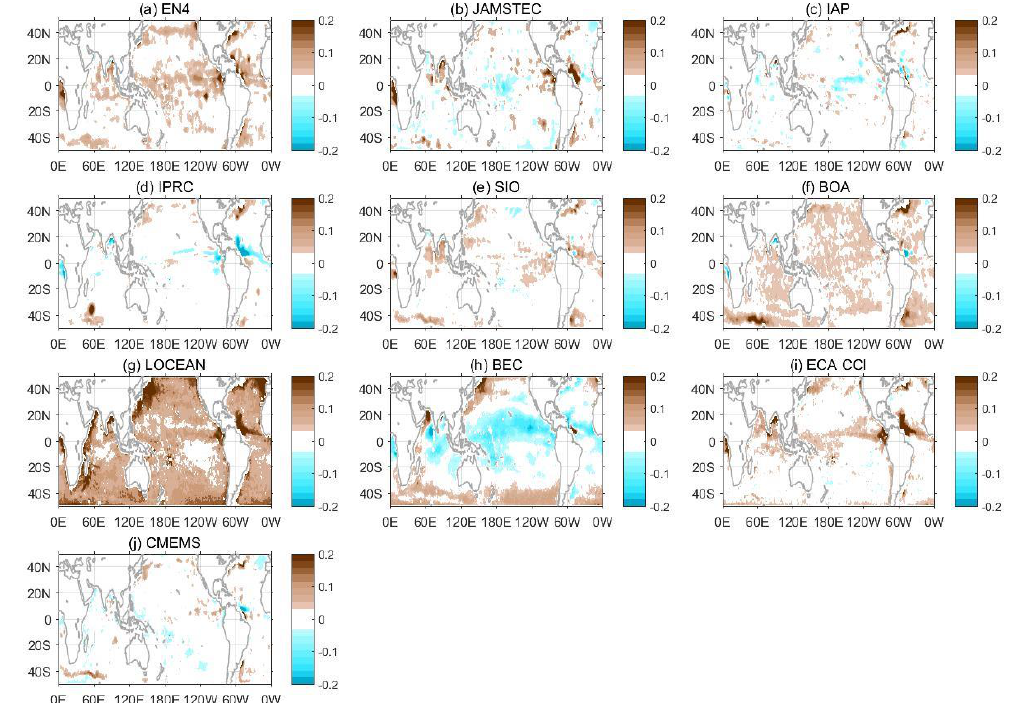
Figure 3. Same as in Figure 2 but for salinity variability, which is denoted by one standard deviation of the monthly fields.